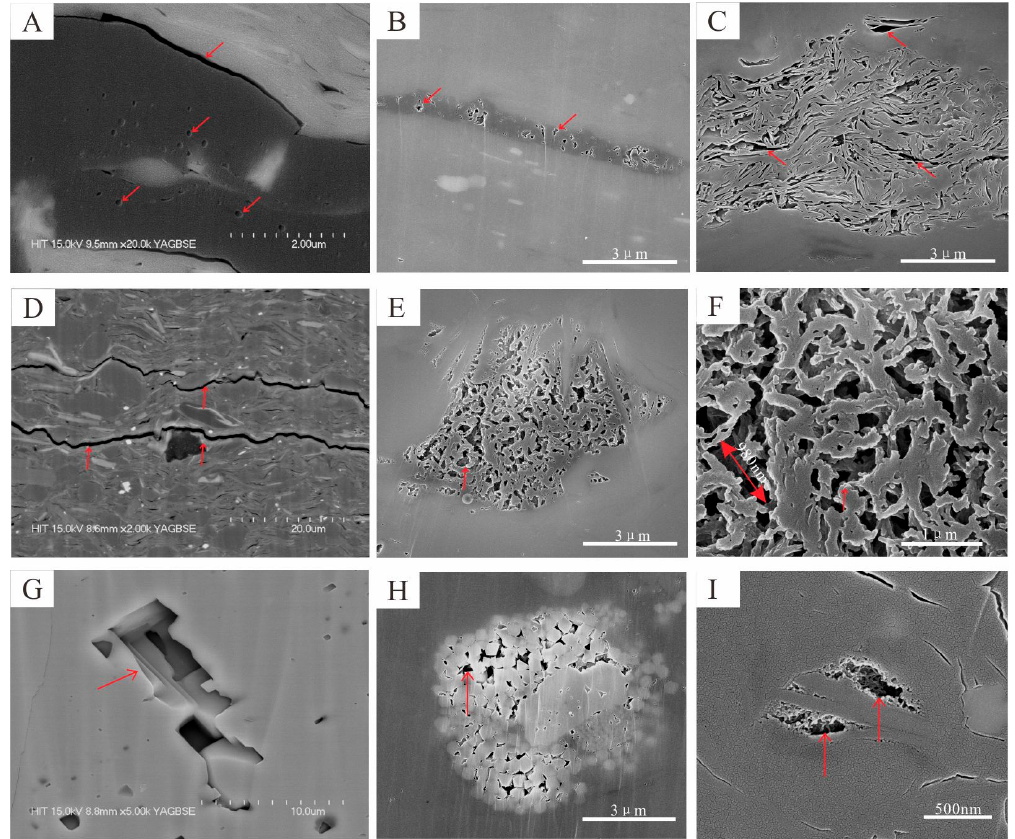
Figure 9. Pore types of the Da’anzhai member shale in the FE-SEM images. ( A ) organic matters-hosted pores and microfractures, CS, 2599.95 m, Well FY1; ( B ) organic matters-hosted pores, AS, 1736.51 m, well FY4; ( C ) interparticle pores between clay minerals, AS, 2543.73 m, well FY5; ( D ) microfractures, 2615 m, CS, well FY1; ( E ) and ( F ) floccule intercrystal pores in flocculated clay microfabric, CS, 2544.36 m, well FY4; ( G ) intercrystalline pores in calcite mineral, ML, 2639.8 m, well FY1; ( H ) intercrystal pores in pyrite framboids, SS, 1736.51 m, well FY4; ( I ) dissolution pores in calcite minerals, MS, 2672.04 m, well 5.